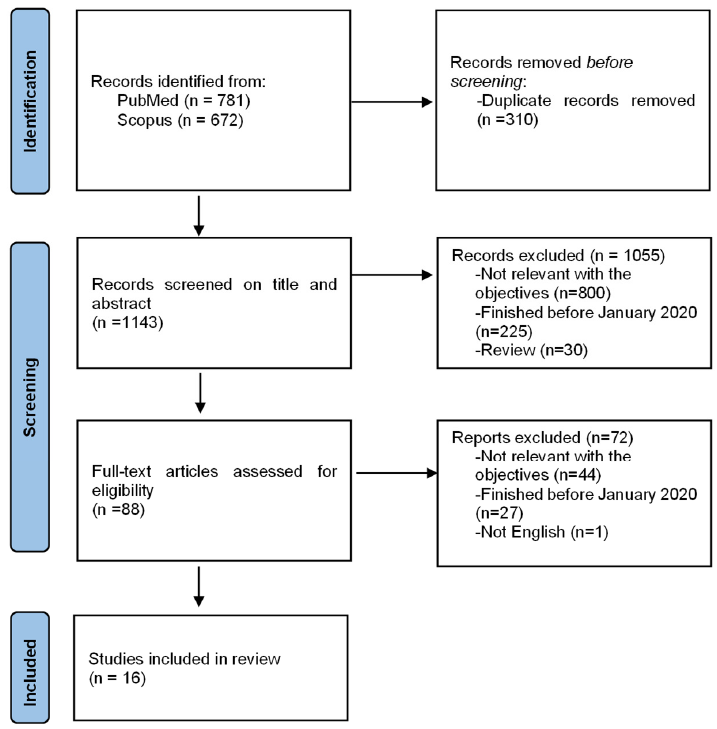
Figure 1. Flow diagram of study selection.